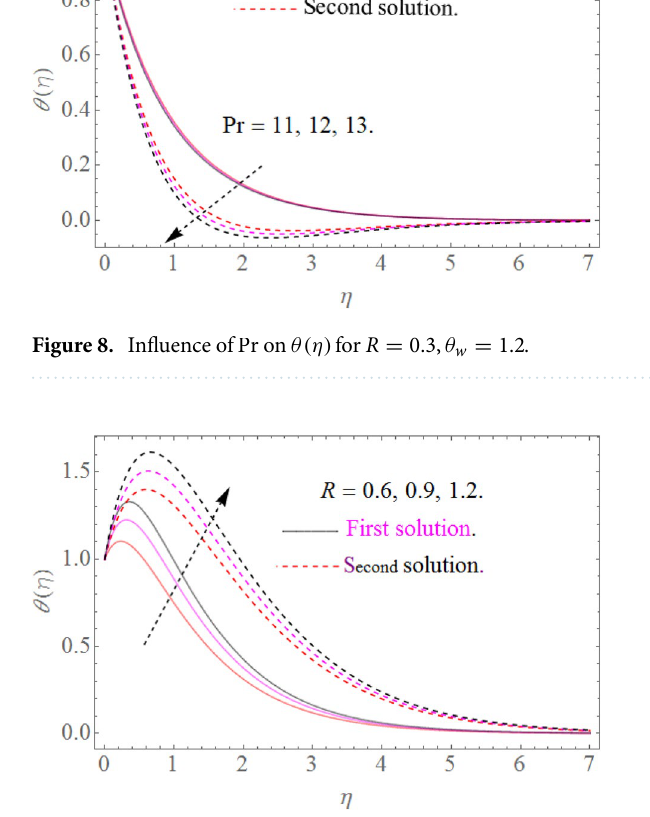
Figure 9. Influence of R on θ(η) for Pr = 10.2, θ w = 1.2 .